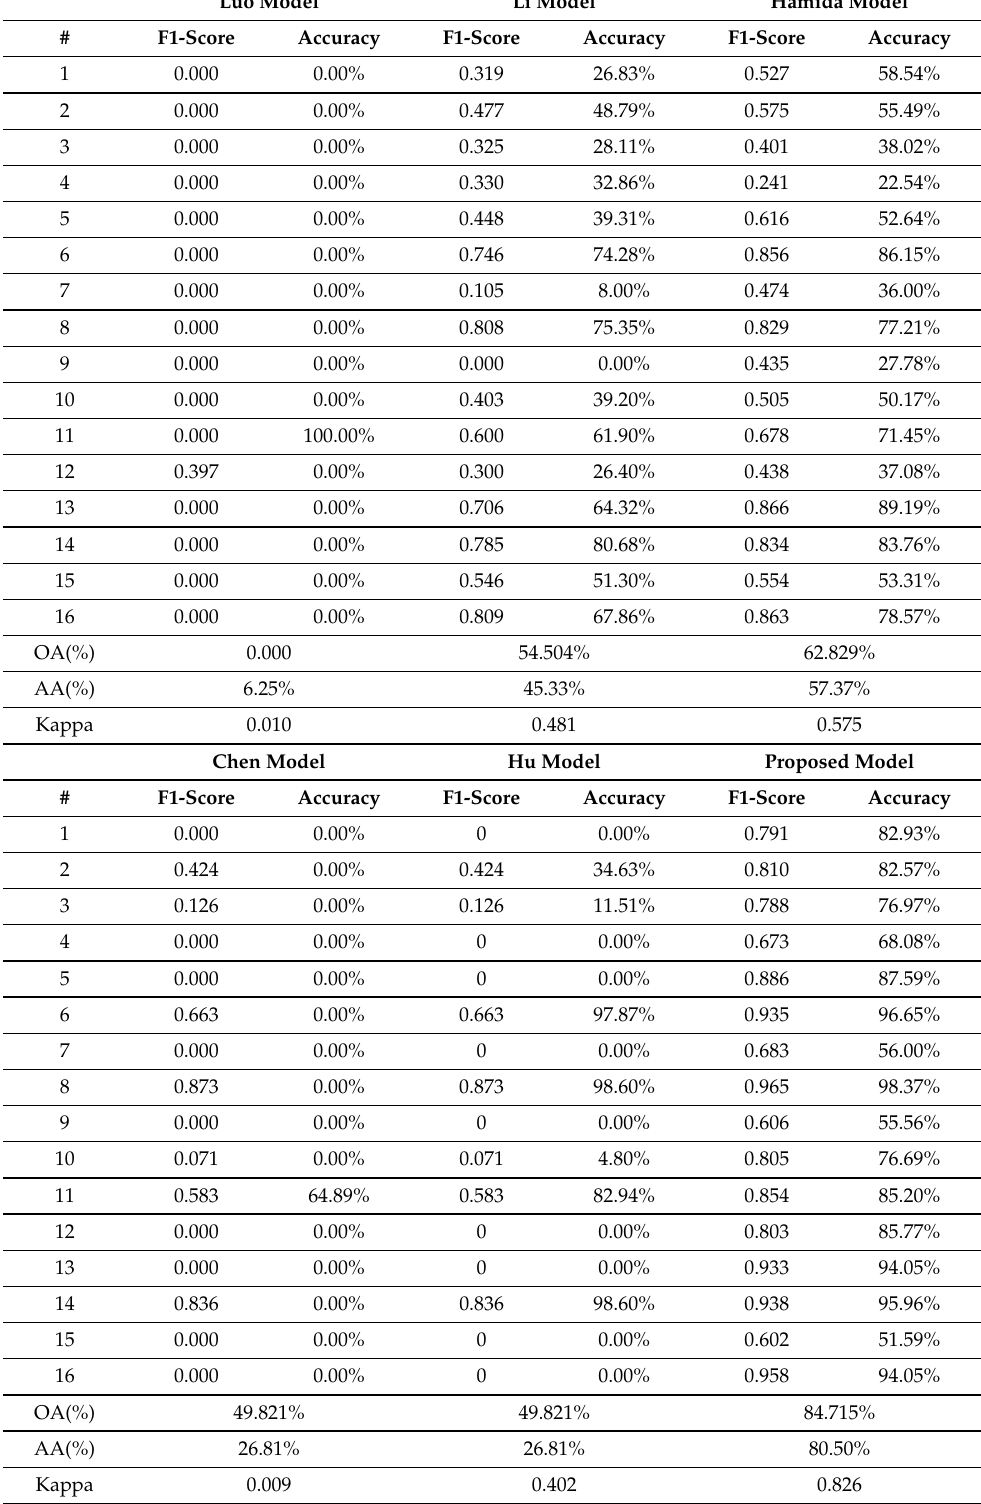
Table 10. Classification results of Indian Pines dataset to which random spatial information is